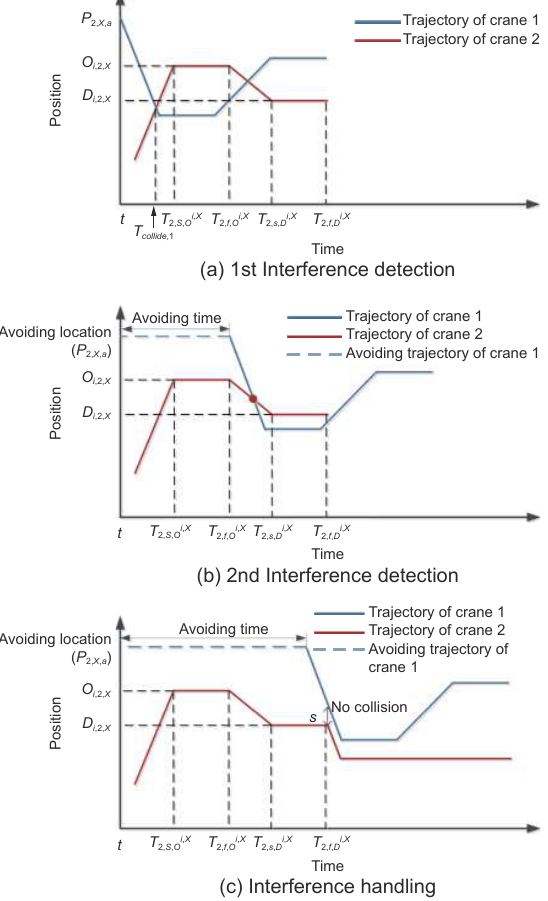
Fig. 9 Avoiding crane without avoidance